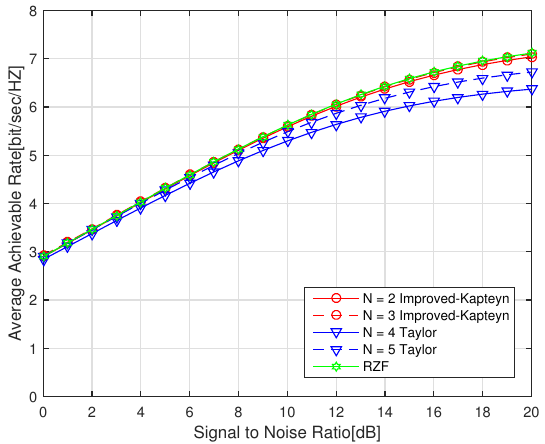
Figure 5. Average achievable rate vs. SINR ( M = 256, K = 32, τ =